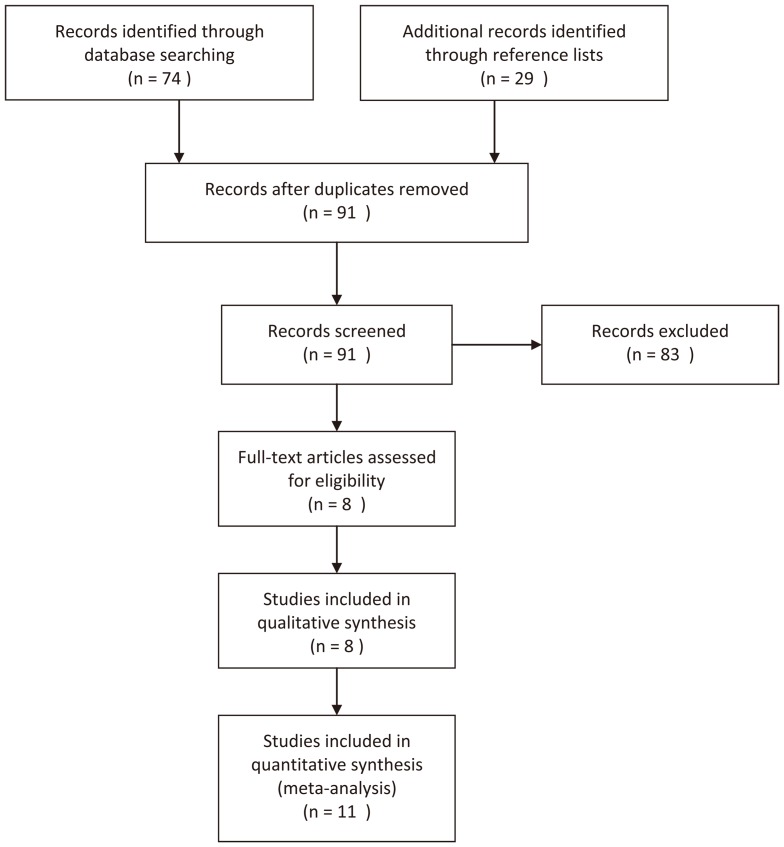
Flow Diagram.*Data from Lu [18] were treated as 2 studies, and data from Naidu [20] were treated as 3 studies.